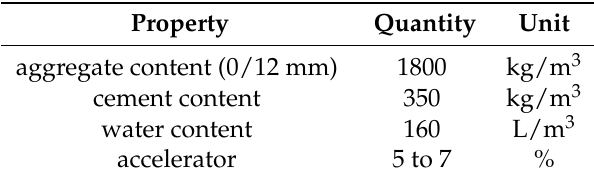
Table 1. Composition of shotcrete for the tests reported by Huber